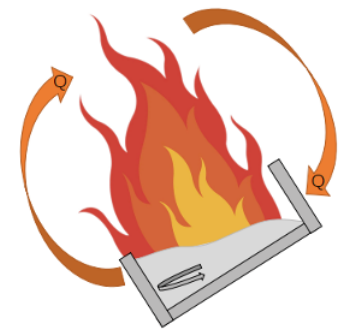
Fig. 8. Thermal cycle during